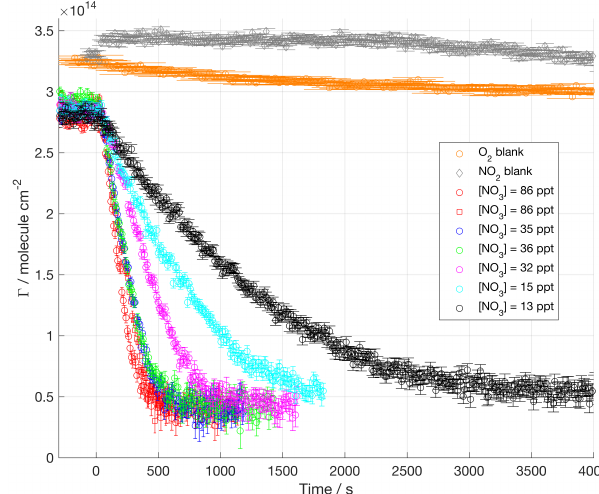
Figure 6. Surface excess decays of palmitoleic acid ( d 14 POA) ex- posed to different [NO 3 ]; mean values are displayed in the leg- end. NO 3 exposure is started at t = 0s. The experimental data are more scattered than those for d 34 OA, because the d 14 POA was half- deuterated (i.e. 14D atoms, see Table 1 in the Supplement), leading to a weaker contrast (i.e. lower signal-to-noise ratio) compared to the fully deuterated molecules studied.